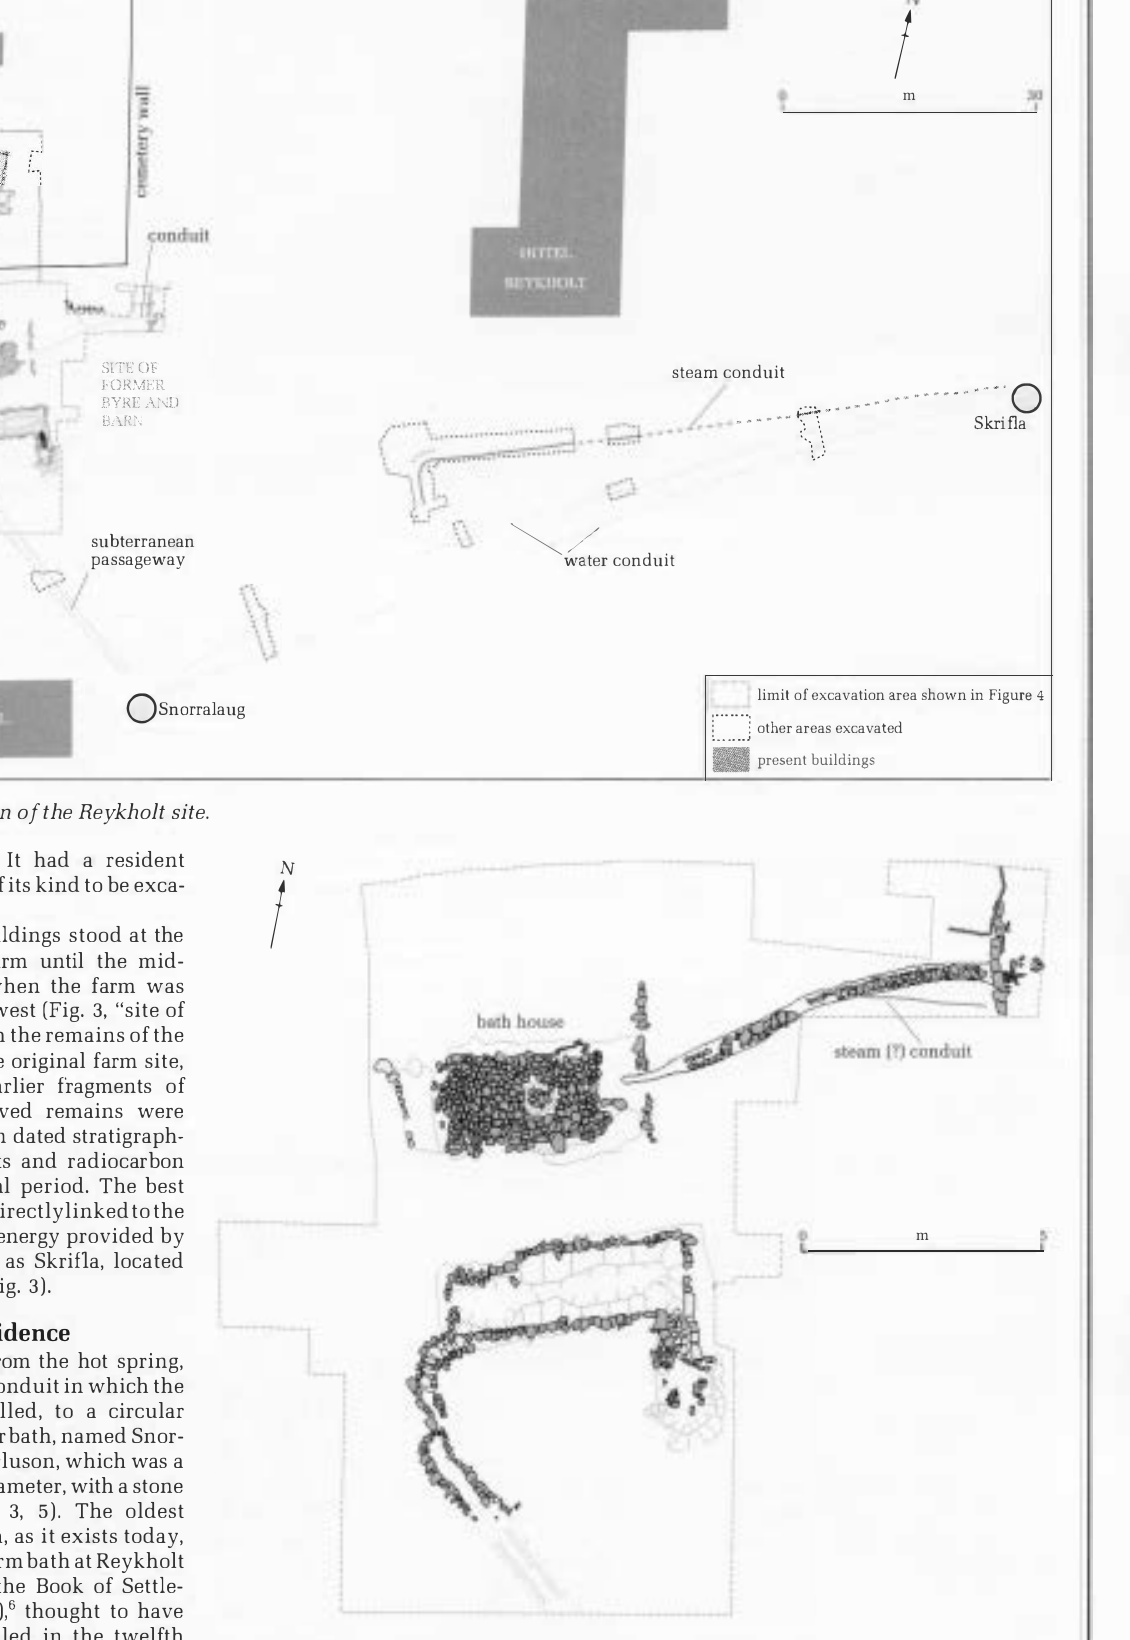
Figure 4 Plan of part of the area excavated at Reykholt showing the subterranean pas­ sageway running into a former building, and, to the north, the putative bath house and the associated (steam?)